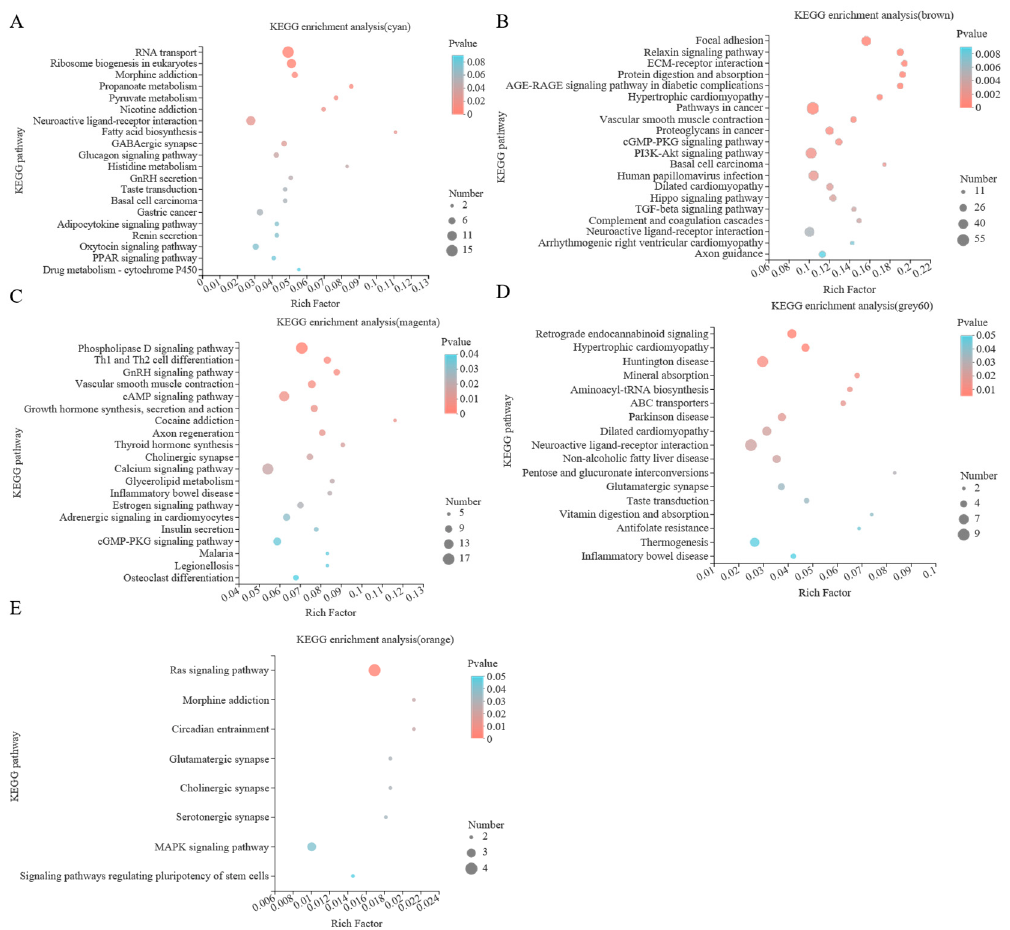
Figure 5. Scatter diagram of KEGG enrichment analysis. ( A ) cyan module, ( B ) brown module, ( C ) magenta module, ( D ) grey60 module, and ( E ) orange module.